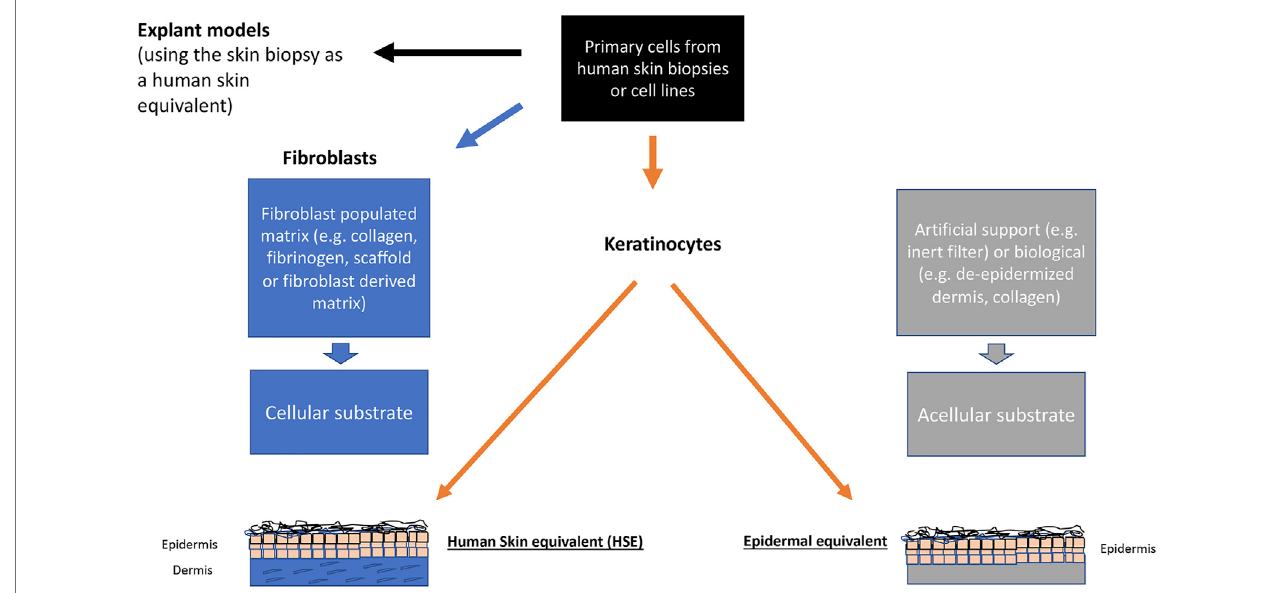
FIGURE 2 | Scheme showing the different in vitro modelling techniques in dermatology and skin